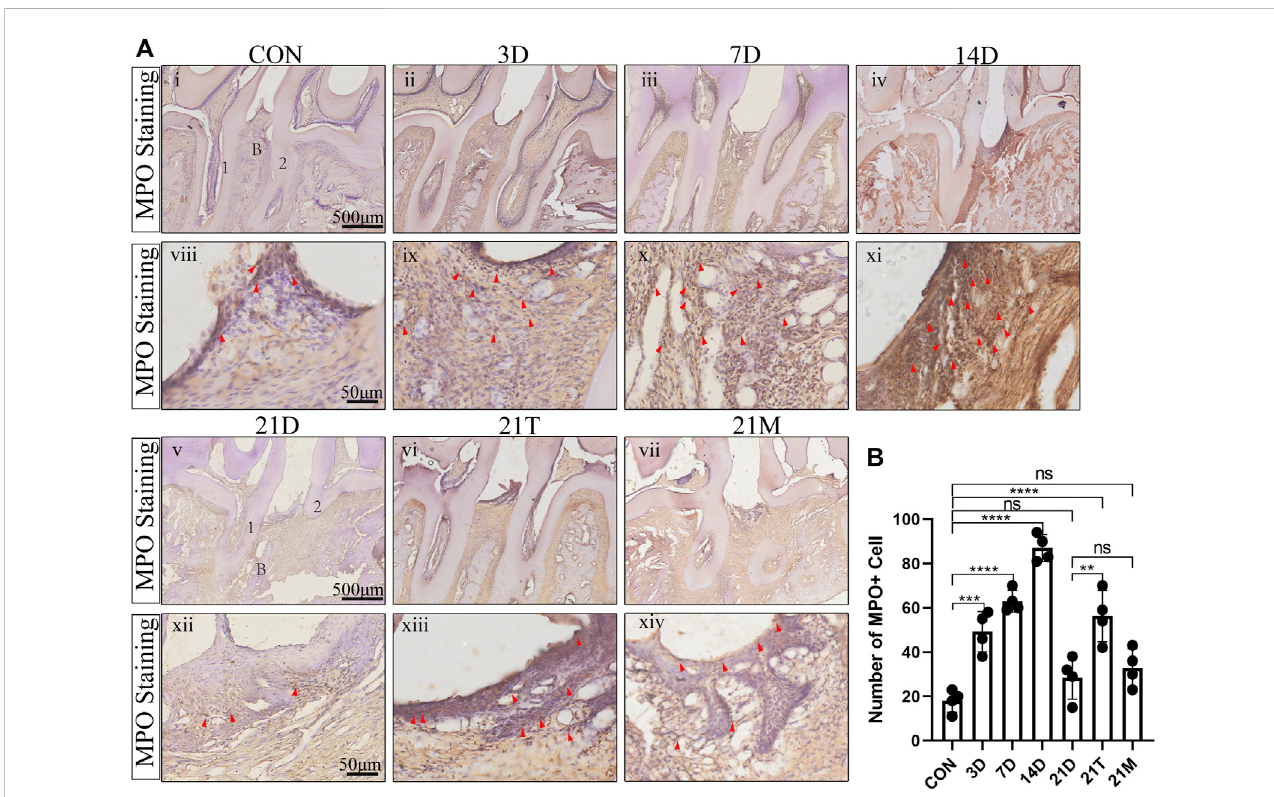
FIGURE 5 The degree of MPO + cells in fi ltration (A) Representative MPO + stained sections of periodontal tissues harvested from each group at low (i-vii) and high (viii-xiv) magni fi cations. 1, the root of the fi rst molar; 2, the root of the second molar; B, alveolar bone. Arrowheads mark MPO + cell. (B) Total MPO + cell number from two random 100 × 100 μ m 2 square areas of thegingiva and periodontal ligament between the second molar and the fi rst molar. Resultsare the mean±s.d.(n=4ratpergroup). p < 0.05, ** p < 0.01,*** p < 0.001,**** p < 0.0001,nsnosigni fi cance(one-wayANOVA andBonferroni ’ s posthoc